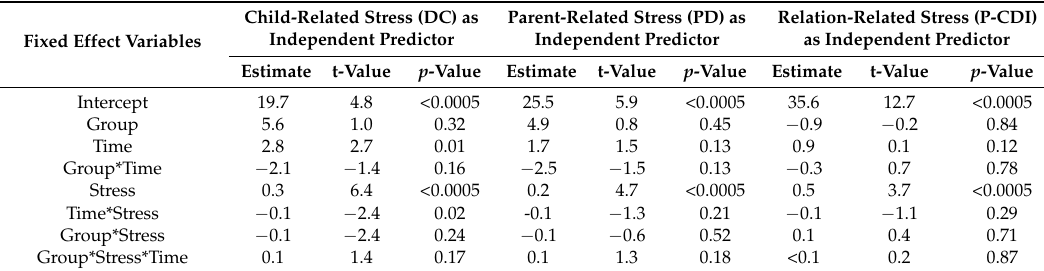
Table A1. Internalizing behavior and stress, maternal reports.